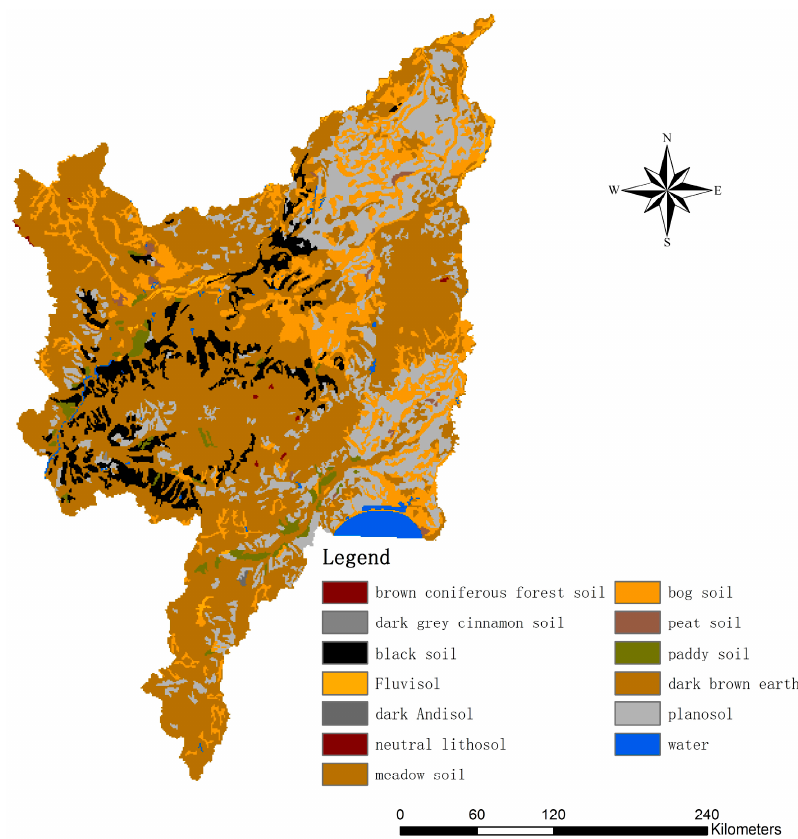
Figure 3. Distribution of soil types in Sanjiang Plain.